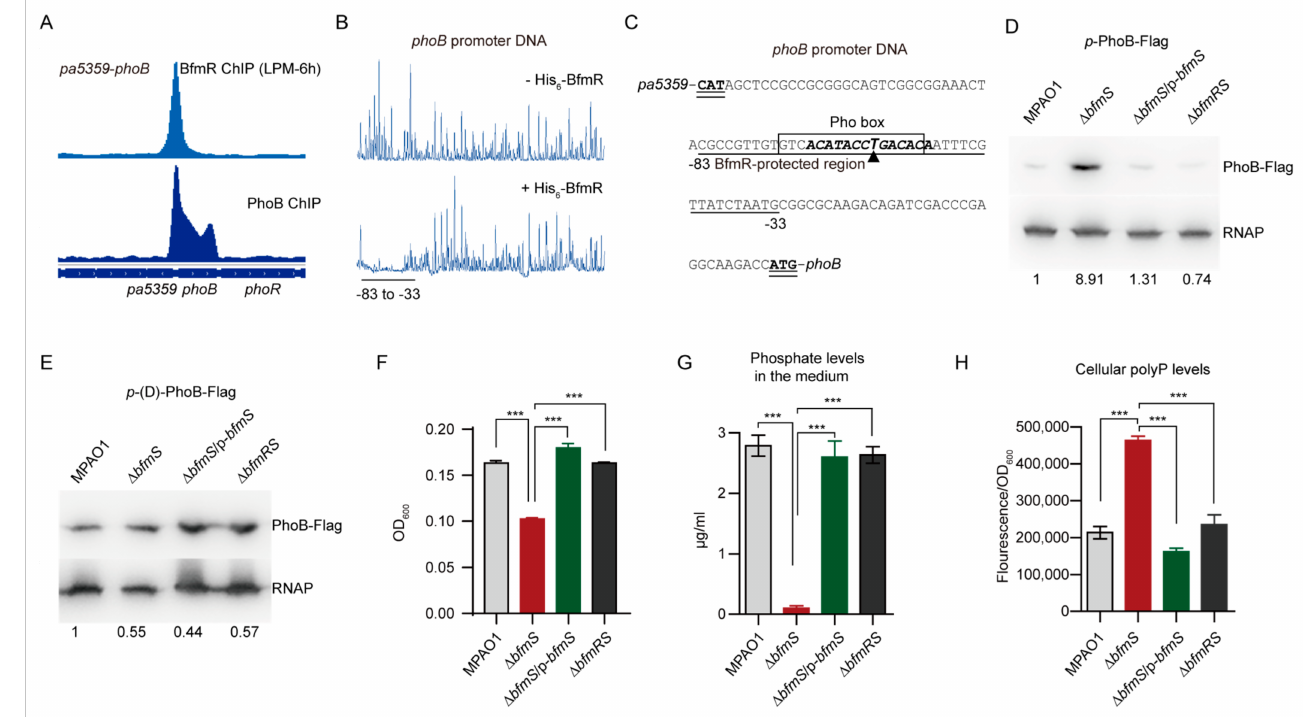
Figure 5. BfmR binds to and activates phoB promoter. ( A ) BfmR and PhoB ChIP-seq signals in phoB promoter. The PhoB ChIP data were obtained from GEO (accession number GSE128430) [58]. ( B ) Electropherogram shows the protection pattern of the phoB promoter DNA after digestion with DNase I following incubation without or with His 6 -BfmR (6 µ M). The protected regions (relative to the start codon of phoB ) are underlined. ( C ) Intergenic sequence of pa5358 and phoB with a summary of the results of DNase I footprint assays and ChIP-seq experiments. The BfmR-protected region (relative to the start codon of phoB ) is underlined; triangle showing the location of the peak summit for BfmR ChIP-seq; sequences that match the MEME motifs of BfmR (see in Figure 1C) are in bold and italic. The potential Pho box [59] is highlighted by square frame, and the starting codons of pa5359 and phoB are in bold and double underlined. ( D , E ) Western blot assays showing the production of PhoB-Flag in P. aeruginosa MPAO1 and its derivatives grown in tubes containing LPM at 37 ◦ C with shaking for 6h. The FLAG-tagged PhoB fusion gene is under the control of a native (in D) or a mutant phoB promoter (in E, lack of GACACA in the BfmR-protected region). The Western blot band intensity of PhoB-Flag was normalized to the intensities obtained with RNA polymerase (RNAP) (used as a loading control) and the results are reported as fold changes with the WT MPAO1 set to 1. MPAO1, ∆ bfmS , and ∆ bfmRS harbor an empty pAK1900 vector as a control; p- bfmS denotes pAK1900- bfmS (Table S1). Data are representative of three biological replicates. ( F ) The growth of P.aeruginosa MPAO1 and its derivatives. Bacteria were grown for 24 h in LPM medium. Results represent means ± SD (n = 3 biological replicates; *** p < 0.001, Student’s two-tailed t -test); OD 600 , an optical density at 600 nm. ( G ) Phosphate removal from the medium. Bacteria were grown for 24 h in LPM medium, and the phosphate level in the spent medium was measured. The initial level of phosphate in the LPM medium is 28 µ g/mL (0.3 mM). ( H ) Measurements of the polyphosphate (polyP) level in WT MPAO1 and its derivatives grown in LPM medium at 37 ◦ C for 24 h. The polyP was quantified using 4’,6’-diamidino-2-phenylindole (DAPI) fluorescence as described in Methods. In (F and G), MPAO1, ∆ bfmS , and ∆ bfmRS harbor an empty pAK1900 vector as a control; p- bfmS denotes pAK1900- bfmS (Table S1); results represent means ± SD (n = 3 biological replicates; *** p < 0.001, Student’s two-tailed